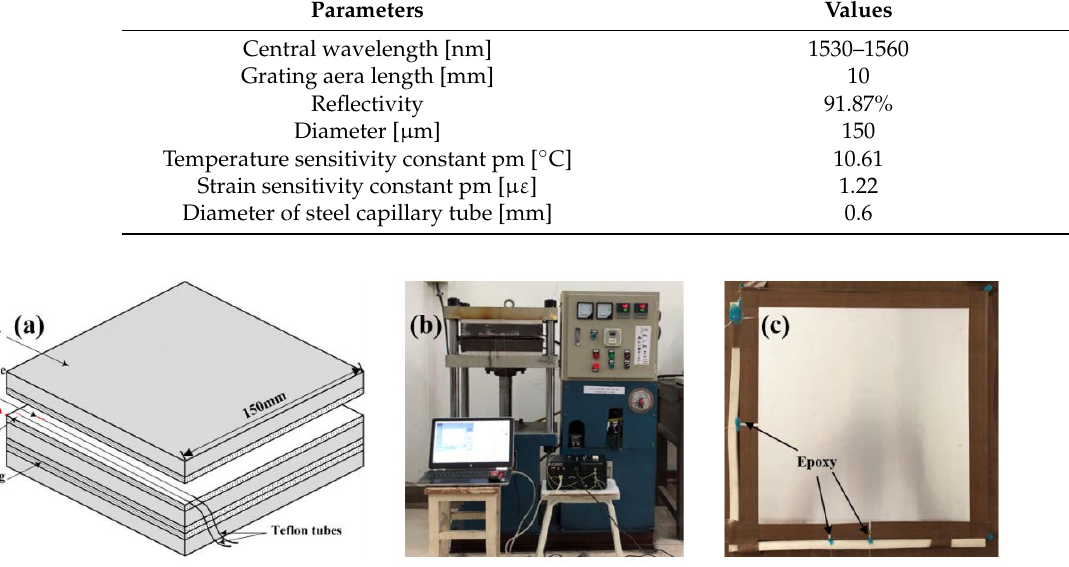
Figure 3. ( a ) The location of FBG sensors in 1/4 GLARE laminate; ( b ) Hot pressing and interrogator; ( c ) The cured